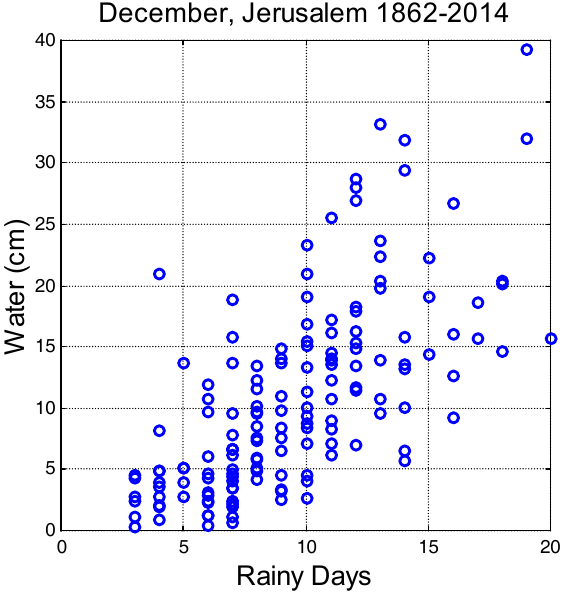
Figure 8. Time series of the number of the rainy days (a) and total quantity of precipitated water (b) expressed in cm of height for a surface of 1 m 2 , in Jerusalem in the month of December, from 1862 to 2014 (153 years). The smoother (red) curves are the results of filtering the original time series by cancelling the components with period less than 10 years. For rainy days the average value is 9.5 days, the standard deviation is 3.8 days. For water, the average value is 10.8 cm with standard deviation 7.8 cm, i.e., 72% of the average.